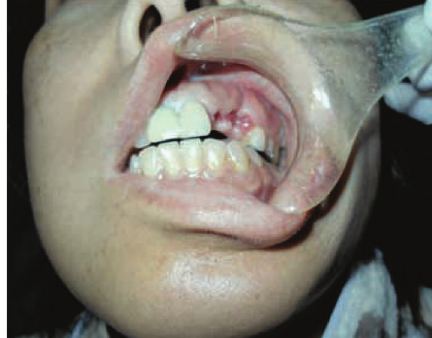
Figure 2: Intraoral view at first medical examination of lacerative scar of the gingiva in the left maxilla.